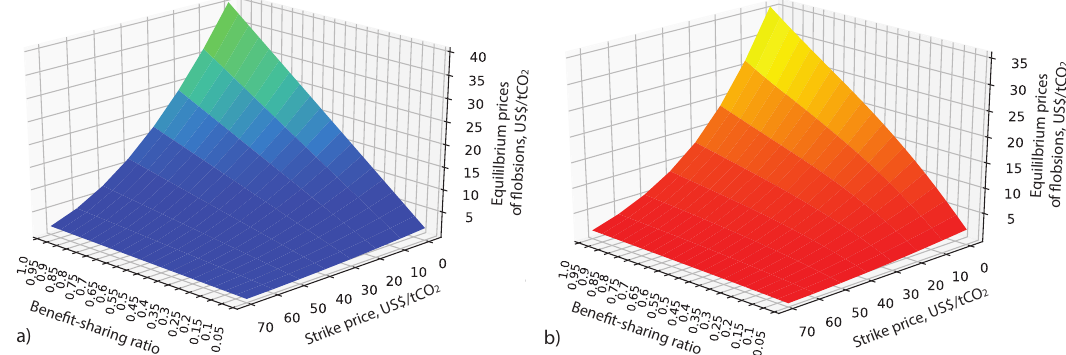
Figure 7. Equilibrium prices of flobsions with respect to benefit-sharing ratio, δ ∈ [ 0.05,1 ] and strike price, p min ∈ [ 0,70 ] : ( a ) risk-neutral case N, ( b ) risk-averse case A3. CO 2 distribution in Equation (19) and opportunity cost in Equation (20), where K =